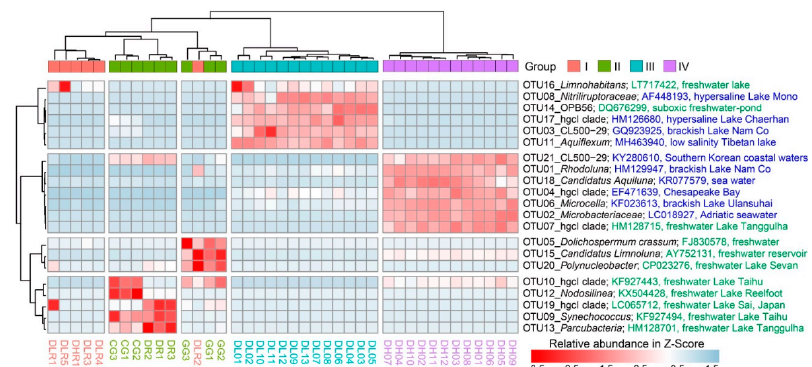
Figure 4. Heatmap of the 21 most abundant OTUs (mean relative abundance > 1%; descending order from OTU01 to OTU21 in abundance) among freshwater rivers (Group I), freshwater lakes (Group II), low-brackish Lake Dalinor (Group III), and high-brackish Lake Daihai (Group IV). The most related counterpart of each OTU was compared using BLAST in the database of the National Center for Biotechnology Information (NCBI). The NCBI access number, and the habitat from which the organism was isolated, are given after the taxonomic information and the OTU number. Information in green denotes that the clones were isolated from freshwater, and information in blue denotes that the clones were isolated from brackish or marine